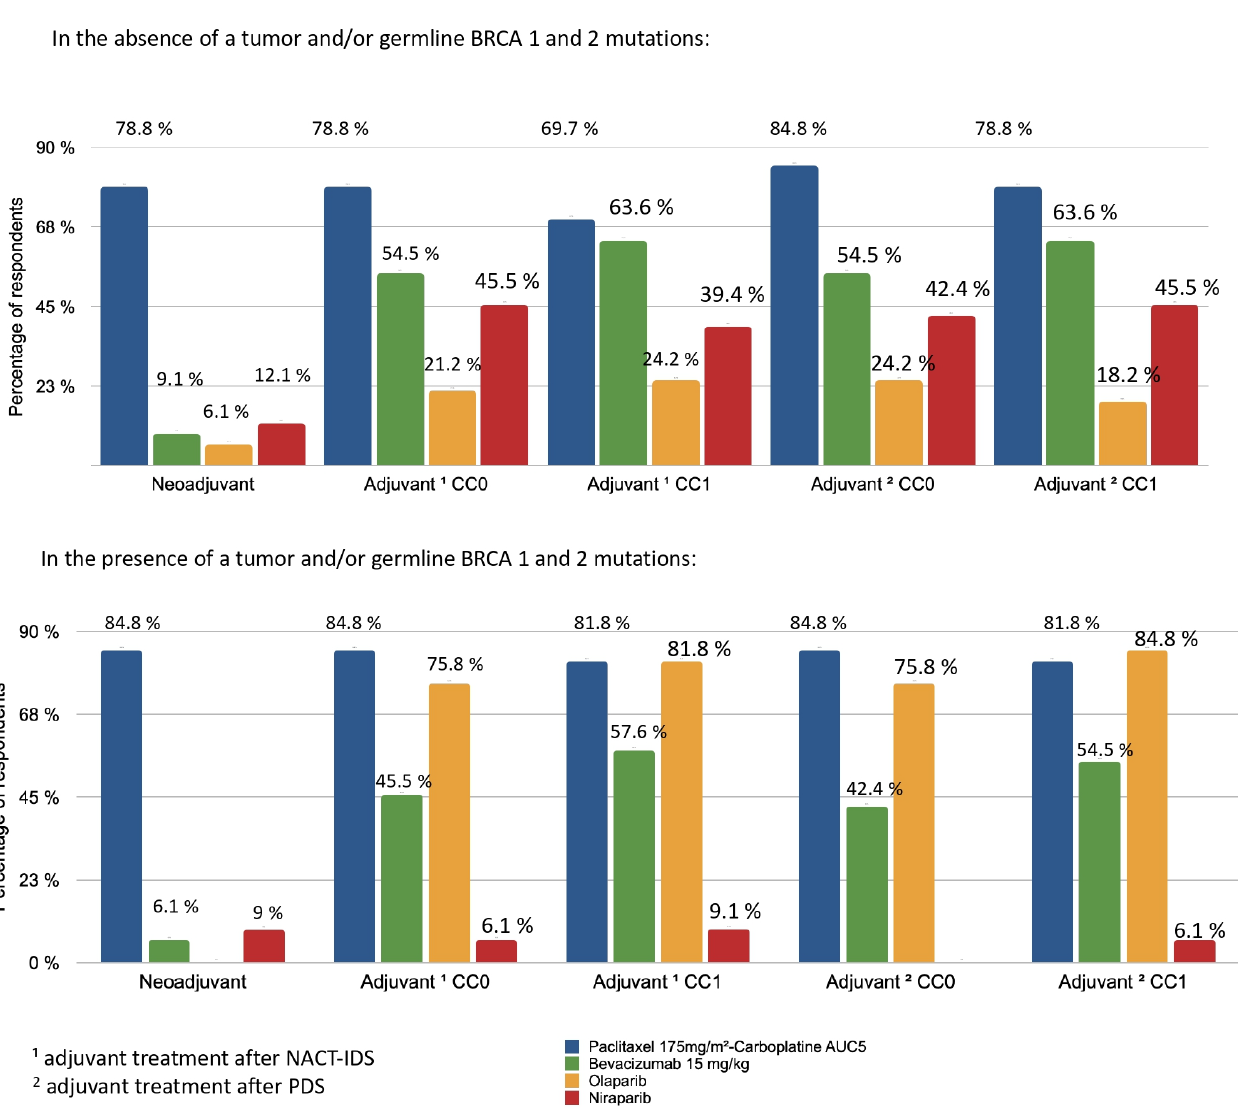
Figure 5. Distribution of treatment indications according to BRCA status and surgery. 1 Adjuvant treatment after neoadjuvant chemotherapy (NACT) and interval debulking surgery (IDS); 2 adjuvant treatment after primary debulking surgery (PDS).